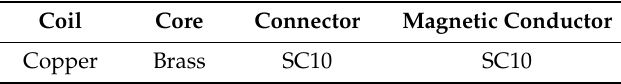
Table 3. Materials of